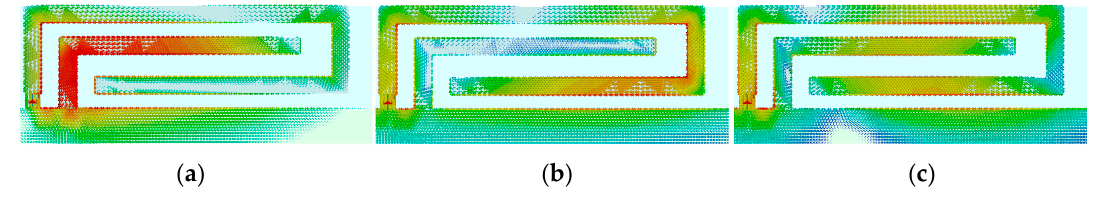
Figure 3. Surface current densities at ( a ) 2.6 GHz, ( b ) 3.6 GHz, and ( c ) 5.8 GHz.